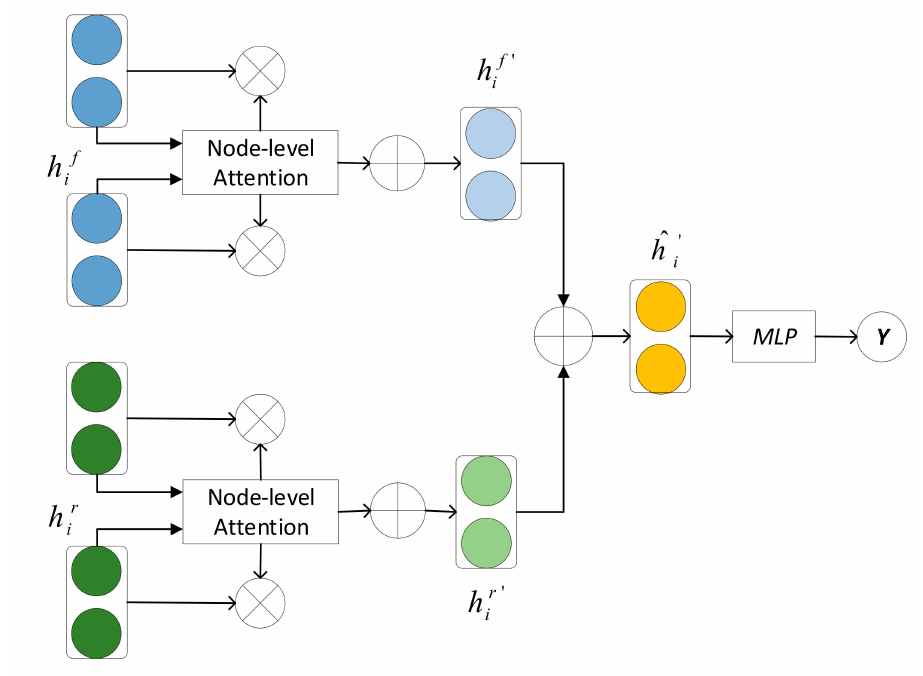
Figure 3. The framework of the proposed